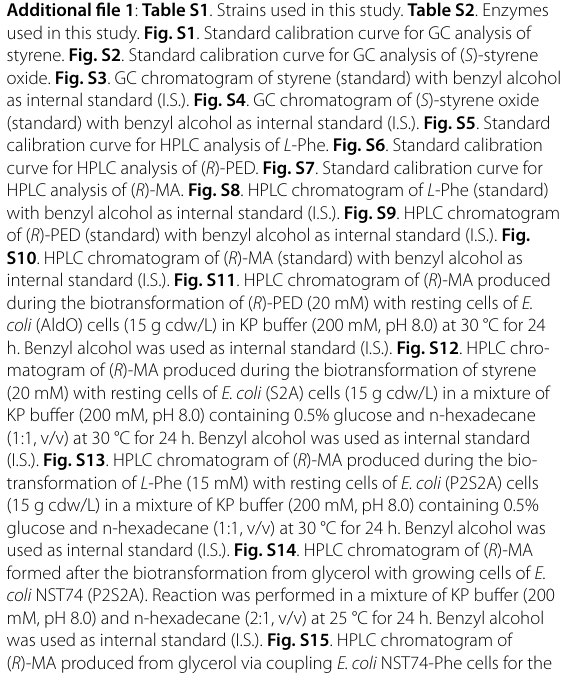
styrene. Fig. S2 . Standard calibration curve for GC analysis of ( S )-styrene oxide. Fig. S3 . GC chromatogram of styrene (standard) with benzyl alcohol as internal standard (I.S.). Fig. S4 . GC chromatogram of ( S )-styrene oxide (standard) with benzyl alcohol as internal standard (I.S.). Fig. S5 . Standard calibration curve for HPLC analysis of L -Phe. Fig. S6 . Standard calibration curve for HPLC analysis of ( R )-PED. Fig. S7 . Standard calibration curve for HPLC analysis of ( R )-MA. Fig. S8 . HPLC chromatogram of L -Phe (standard) with benzyl alcohol as internal standard (I.S.). Fig. S9 . HPLC chromatogram of ( R )-PED (standard) with benzyl alcohol as internal standard (I.S.). Fig. S10 . HPLC chromatogram of ( R )-MA (standard) with benzyl alcohol as internal standard (I.S.). Fig. S11 . HPLC chromatogram of ( R )-MA produced during the biotransformation of ( R )-PED (20 mM) with resting cells of